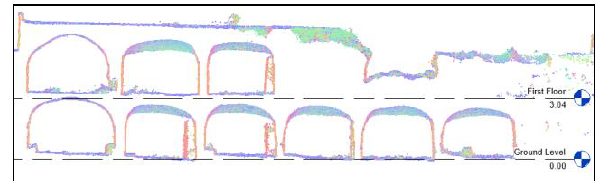
Figure 14. Vertical section of the north chambers of the Grand